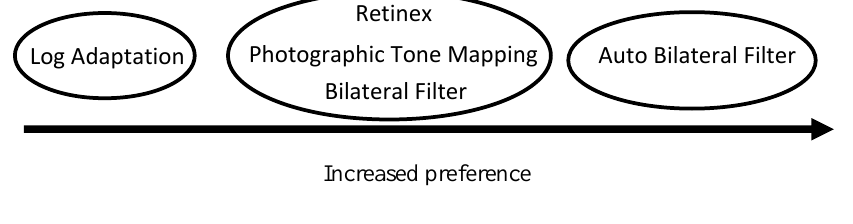
Figure 11. Diagram summarizing the paired comparison results of the second psychophysical experiment. Algorithms are listed from left to right in order of increased preference; in terms of how much visual information or detail seemed to be visible by test